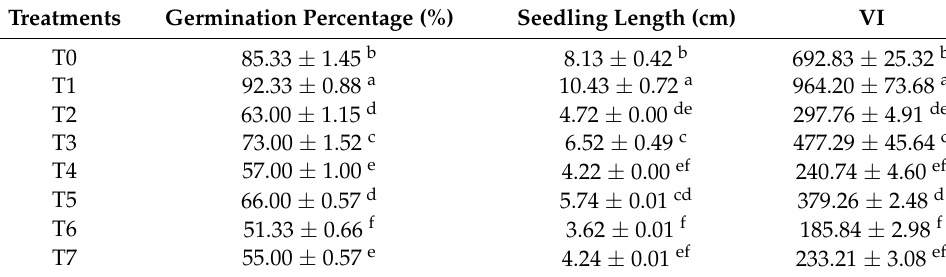
Table 2. Effect of chromium stress and B. cereus inoculation on germination attributes of Brassica nigra . Treatments